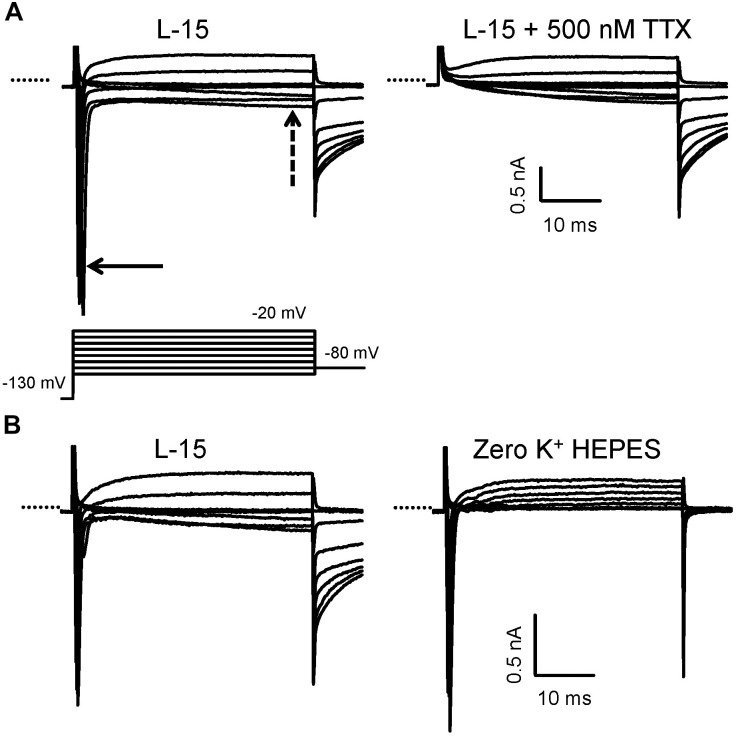
Isolation of Na+ currents in whole cell voltage clamp in calyces from the mature crista. (A) A family of currents was evoked in response to the standard voltage protocol consisting of a 40 ms step to –130 mV from a holding potential of –80 mV, followed by a series of 40 ms depolarizing steps in 10 mV increments (last part of protocol shown). Large and rapid inward currents (solid arrow) developed at steps to membrane potentials above –70 mV and were followed by a slowly developing inward current (dashed arrow) in standard L-15 solution. At more positive potentials, the inward current became outward. Perfusion with 500 nM TTX (right) abolished the transient inward current, indicating it was carried by TTX-sensitive Na+ channels, but the sustained inward current remained. PZ calyx, P25. (B) Control currents in L-15 in another cell followed by perfusion with zero K+ HEPES solution revealed that INa persisted, but the slow inward current was abolished. CZ calyx, P22. Electrode solution contained Cs+. In this and subsequent figures, capacitance transients have been truncated for clarity and the dotted line indicates zero current level.